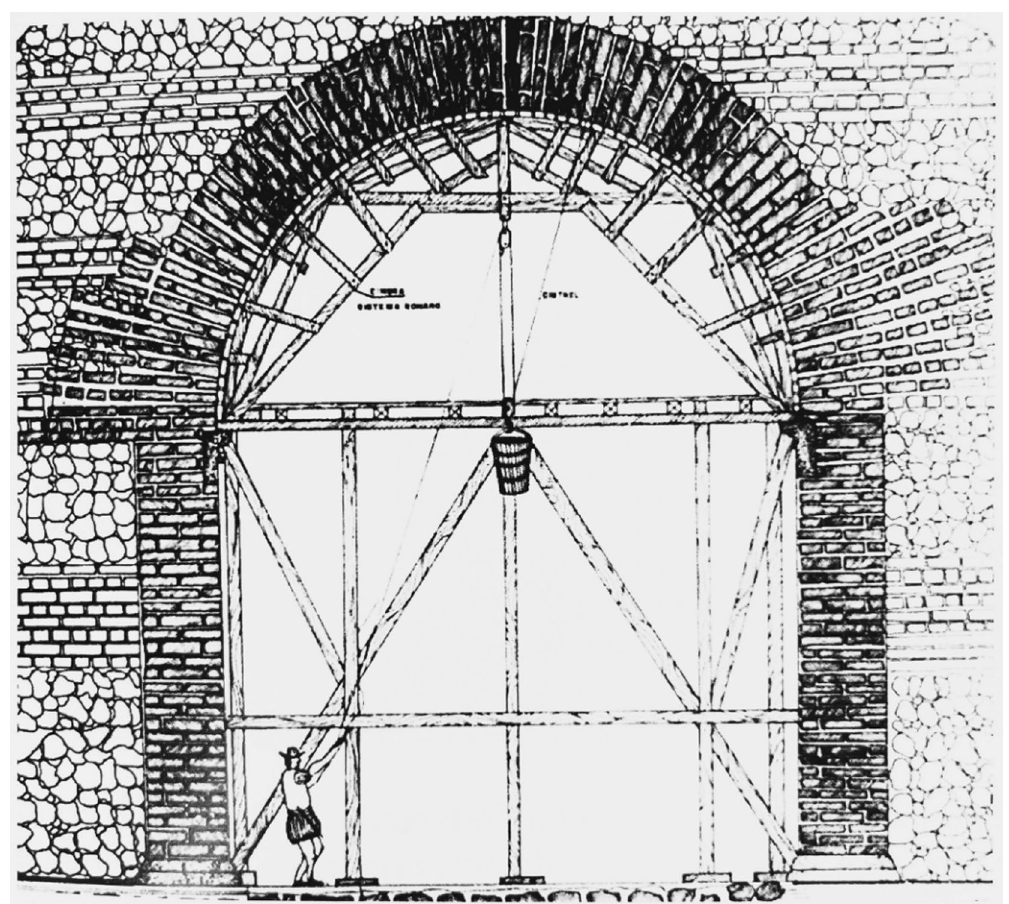
Fig. 11 Half point arch in brick of the San Fernando de Bocachica castle, (Cabrera Cruz et al.